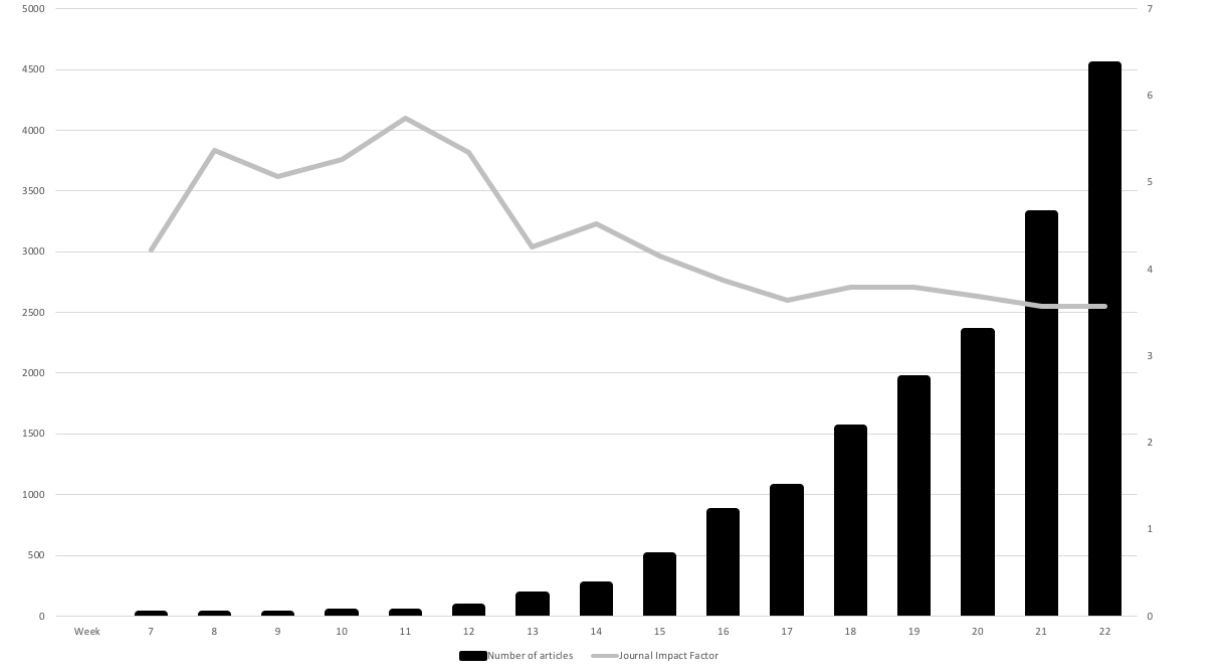
Figure 2. Number of articles published per week and the corresponding median journal impact factor.